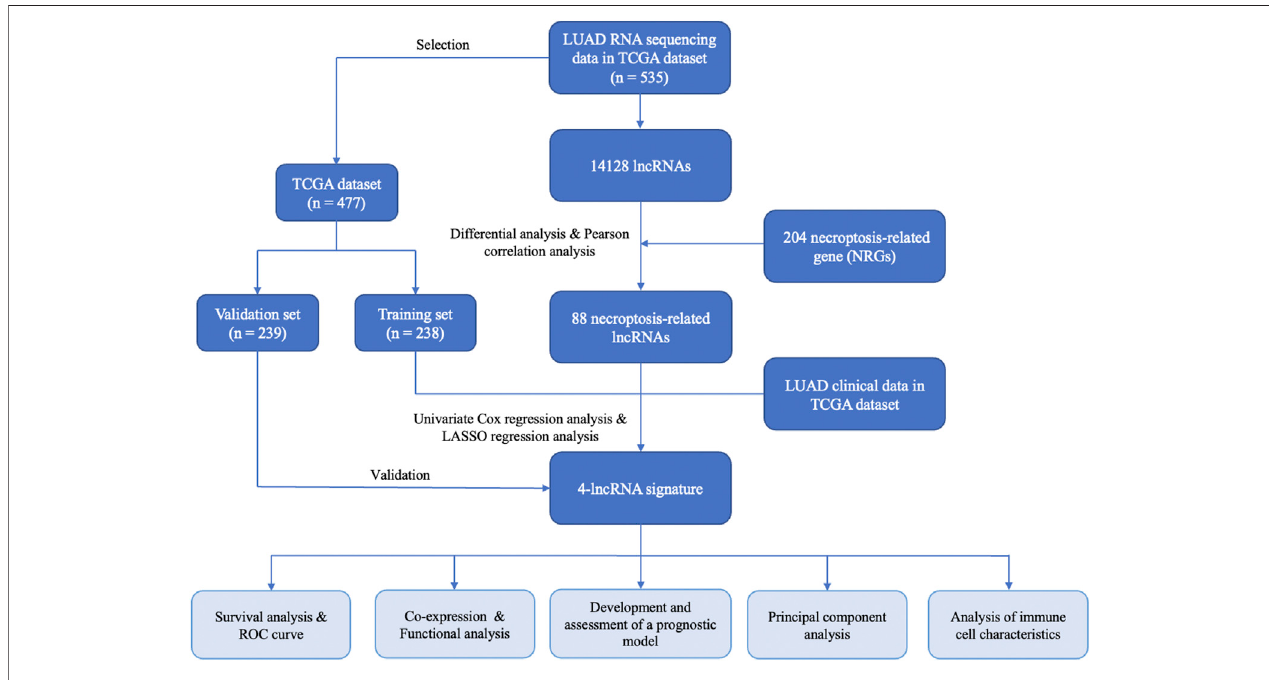
FIGURE 1 | The fl ow chart of key steps in this study.